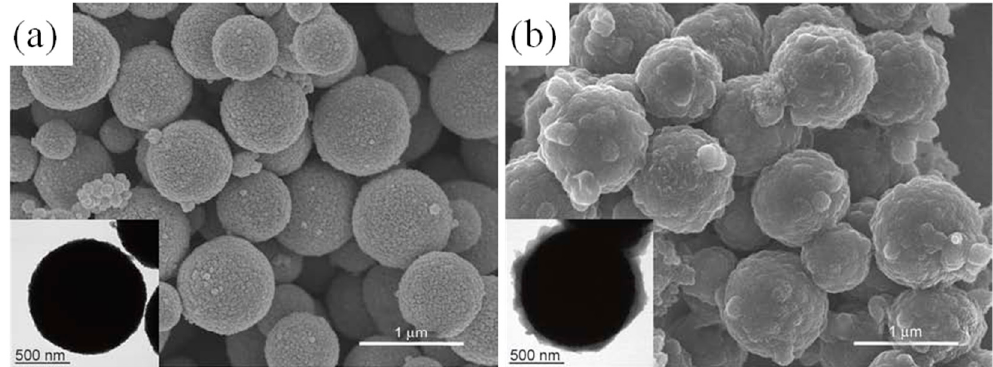
Figure 3. SEM and TEM (inset) images of ( a ) Fe 3 O 4 , ( b ) Fe 3 O 4 @PANI (Sim et al. [109], Copyright BME-PT, 2015).